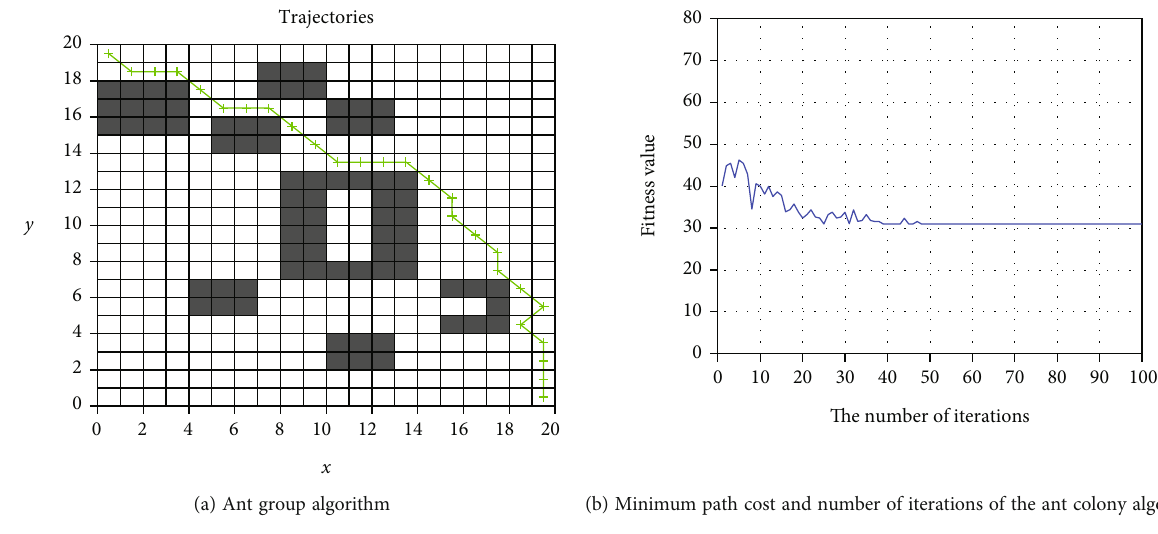
Figure 4: Simulation results of the ant colony algorithm.